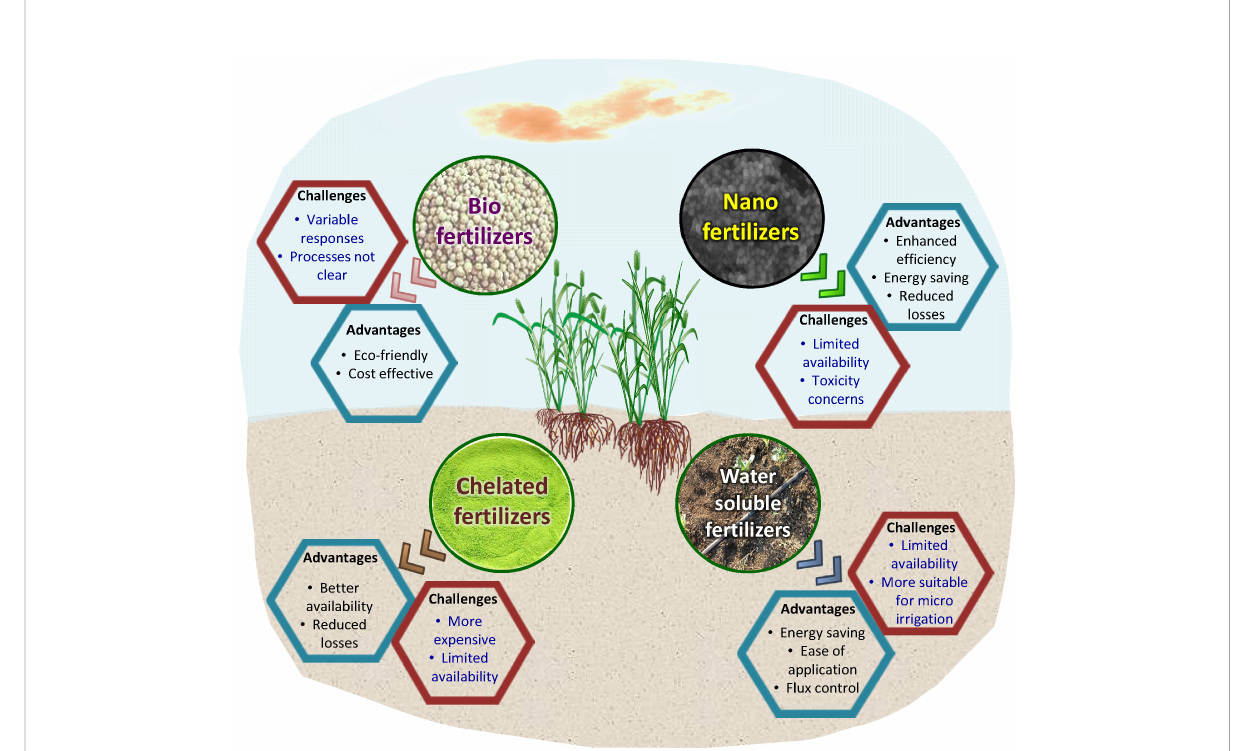
FIGURE 4 Advancements in fertilizer forms to increase the ef fi ciency and relevance of agronomic bioforti fi